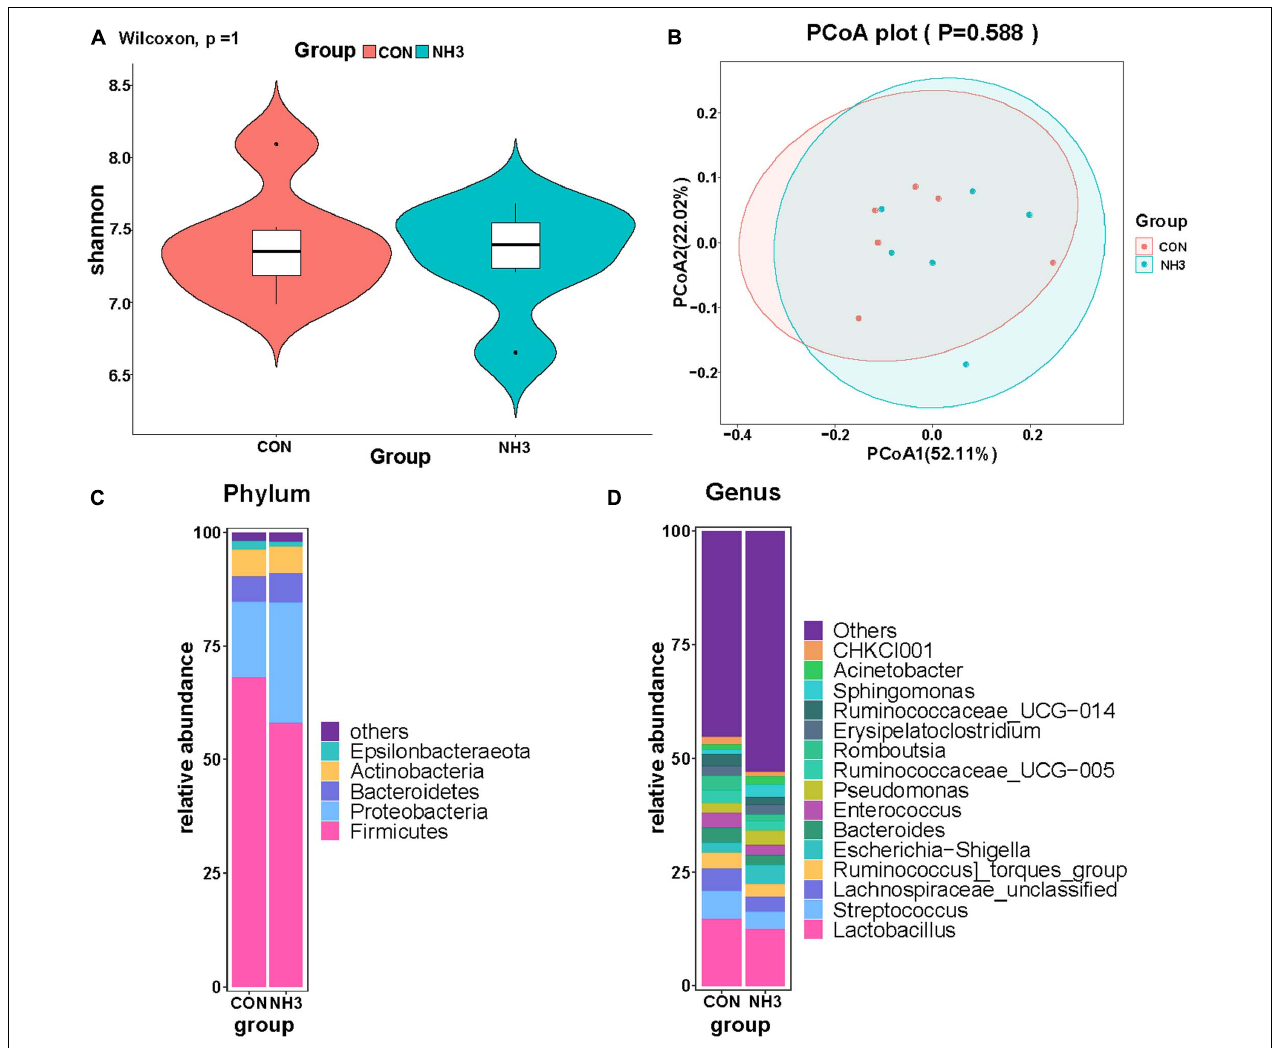
FIGURE 7 | Effect of ammonia exposure on broiler lung microbiota. (A) Alpha diversity analysis was performed using the Shannon index. (B) Principal coordinates analysis (PCoA) of weighted UniFrac distances as a measure of beta diversity. (C) The stack graph of microbiota in major phyla at phylum level. (D) The stack graph of microbiota in major phyla at genus